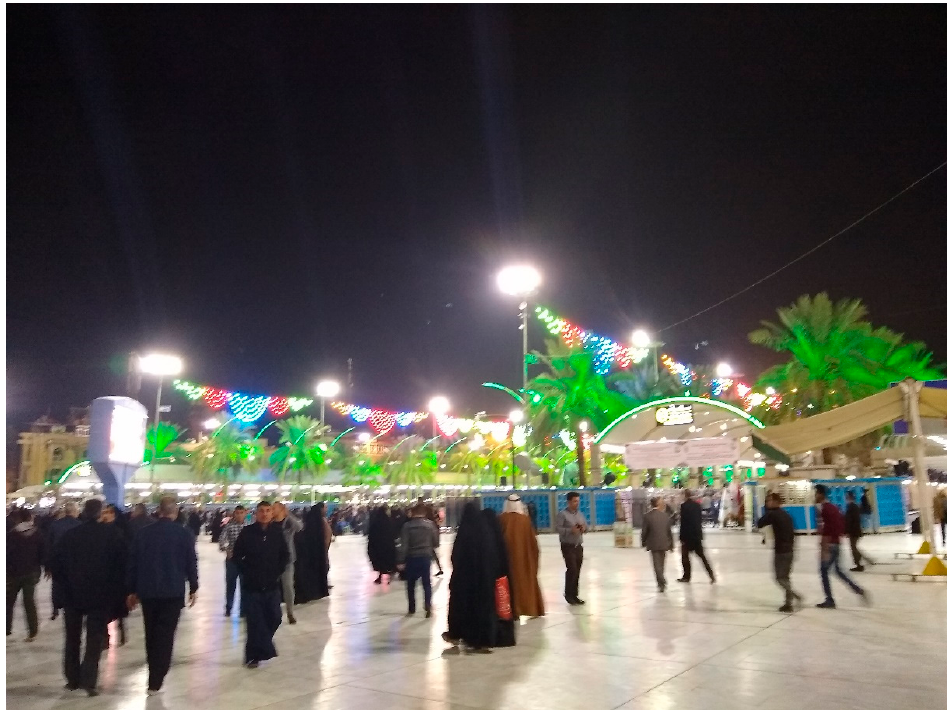
Figure 3. The Imam Abbas and Imam Hussein shrine area in Karbala, November 2018. A survey of the area failed to detect any depression that might be associated with the traces of the Khandaq Shapur.